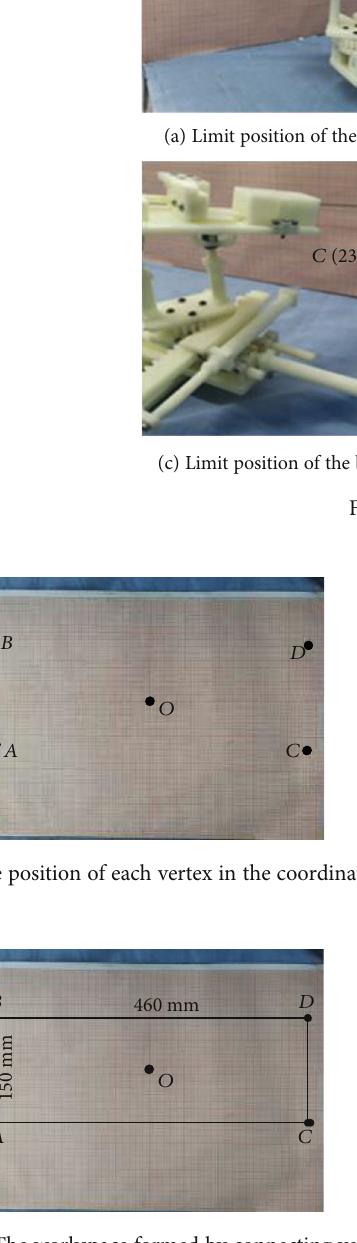
Figure 22: The workspace formed by connecting vertices.